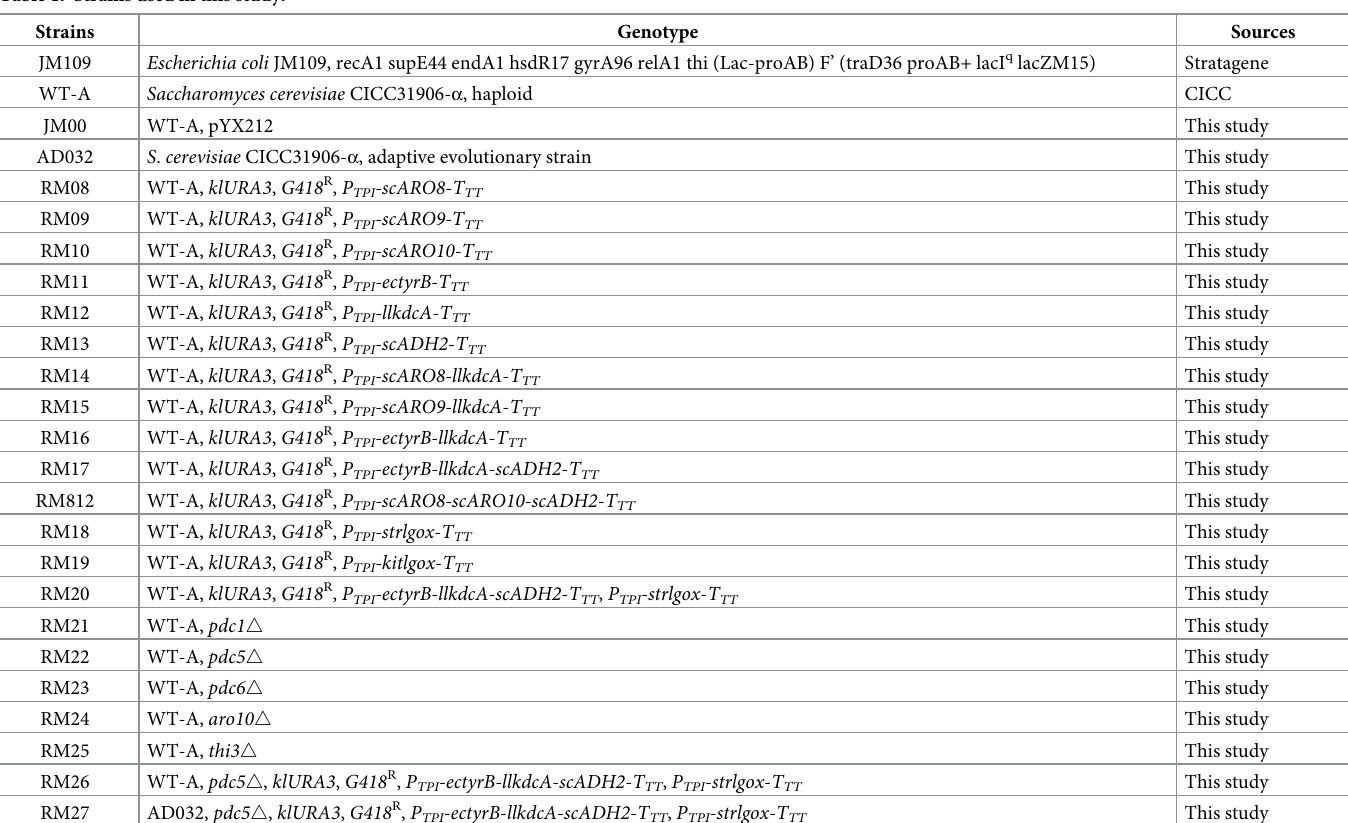
Table 1. Strains used in this study. Strains